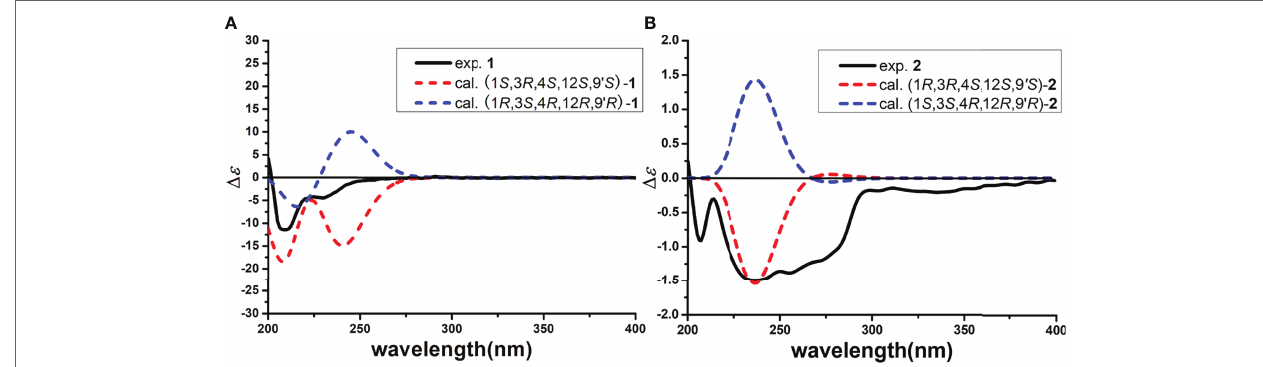
FIGURE 5 | Experimental and calculated ECD spectra of compounds 1 (A) and 2 (B)